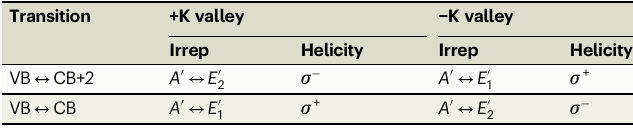
Table 1 | The selection rules of the group C 3h at +K and − K valleys for circularly polarized PL Transition +K